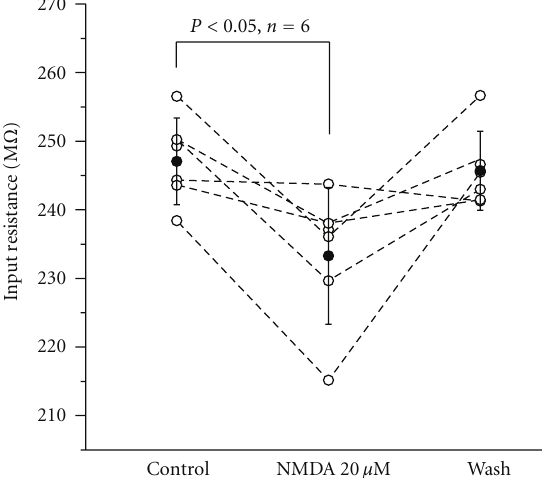
Figure 2: A decrease of input resistance induced by NMDA in RA projection neurons. The input resistance was decreased to 233 . 29 ± 9 . 97 M Ω after application of 20 μ M NMDA from 247 . 07 ± 6 . 31 M Ω and was recovered to 245 . 72 ± 5 . 75M Ω after wash for 10 min. Individual cells are shown as open circles, and the average of each group is shown as an closed circle. P < 0 . 05 ( n = 6, paired t -test).